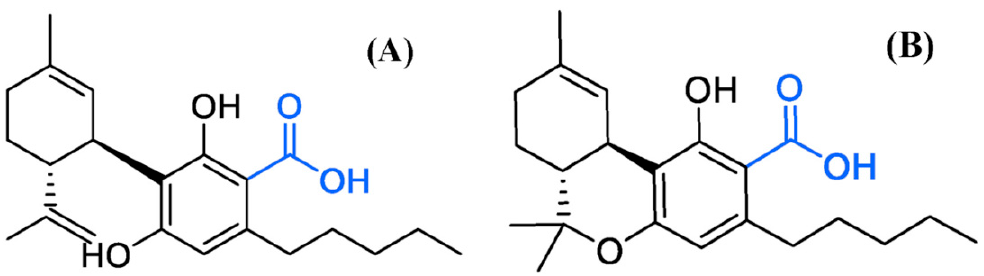
Figure 1. Carboxyl group of acid cannabinoids. ( A ) Cannabidiolic acid, ( B ) ∆ 9-tetrahydrocannabinolic acid. Carboxyl groups are removed by heat treatment and converted into neutral cannabinoids.